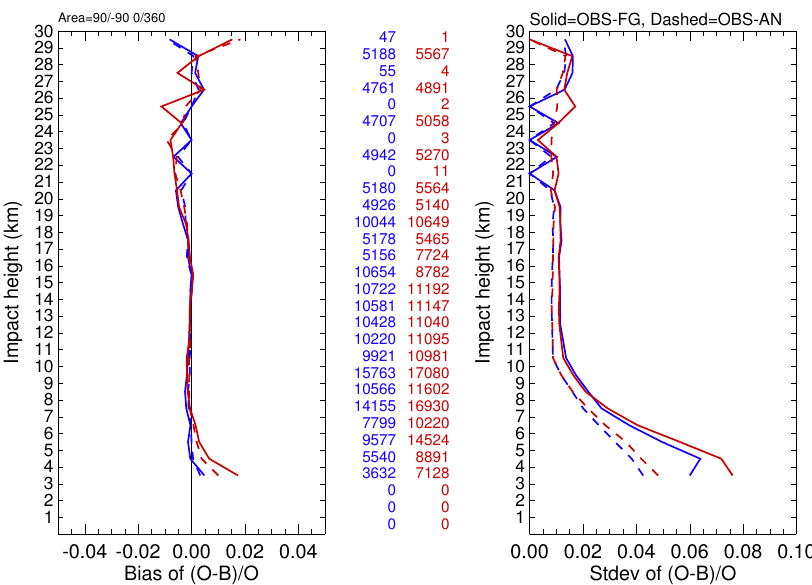
Fig. 6. The global mean (left) and standard deviation (right) of observation minus first-guess (continuous lines) and observation minus analysis (dashed lines) of the TerraSAR-X (blue) bending angle departures for impact heights from 3km to 30km, and compared to COSMIC FM-1 (red). The departures are normalized with respect to the observed bending angles. The statistics is based on 28days of data (22 October to 18 November 2010). The central columns display the number of samples passing first-guess checks and being used after the variational quality control within a 1-km interval (left: TerraSAR-X, right: COSMIC). Impact heights between 21–22km, 23–24km, and 25–26km were sparsely populated after vertical thinning.